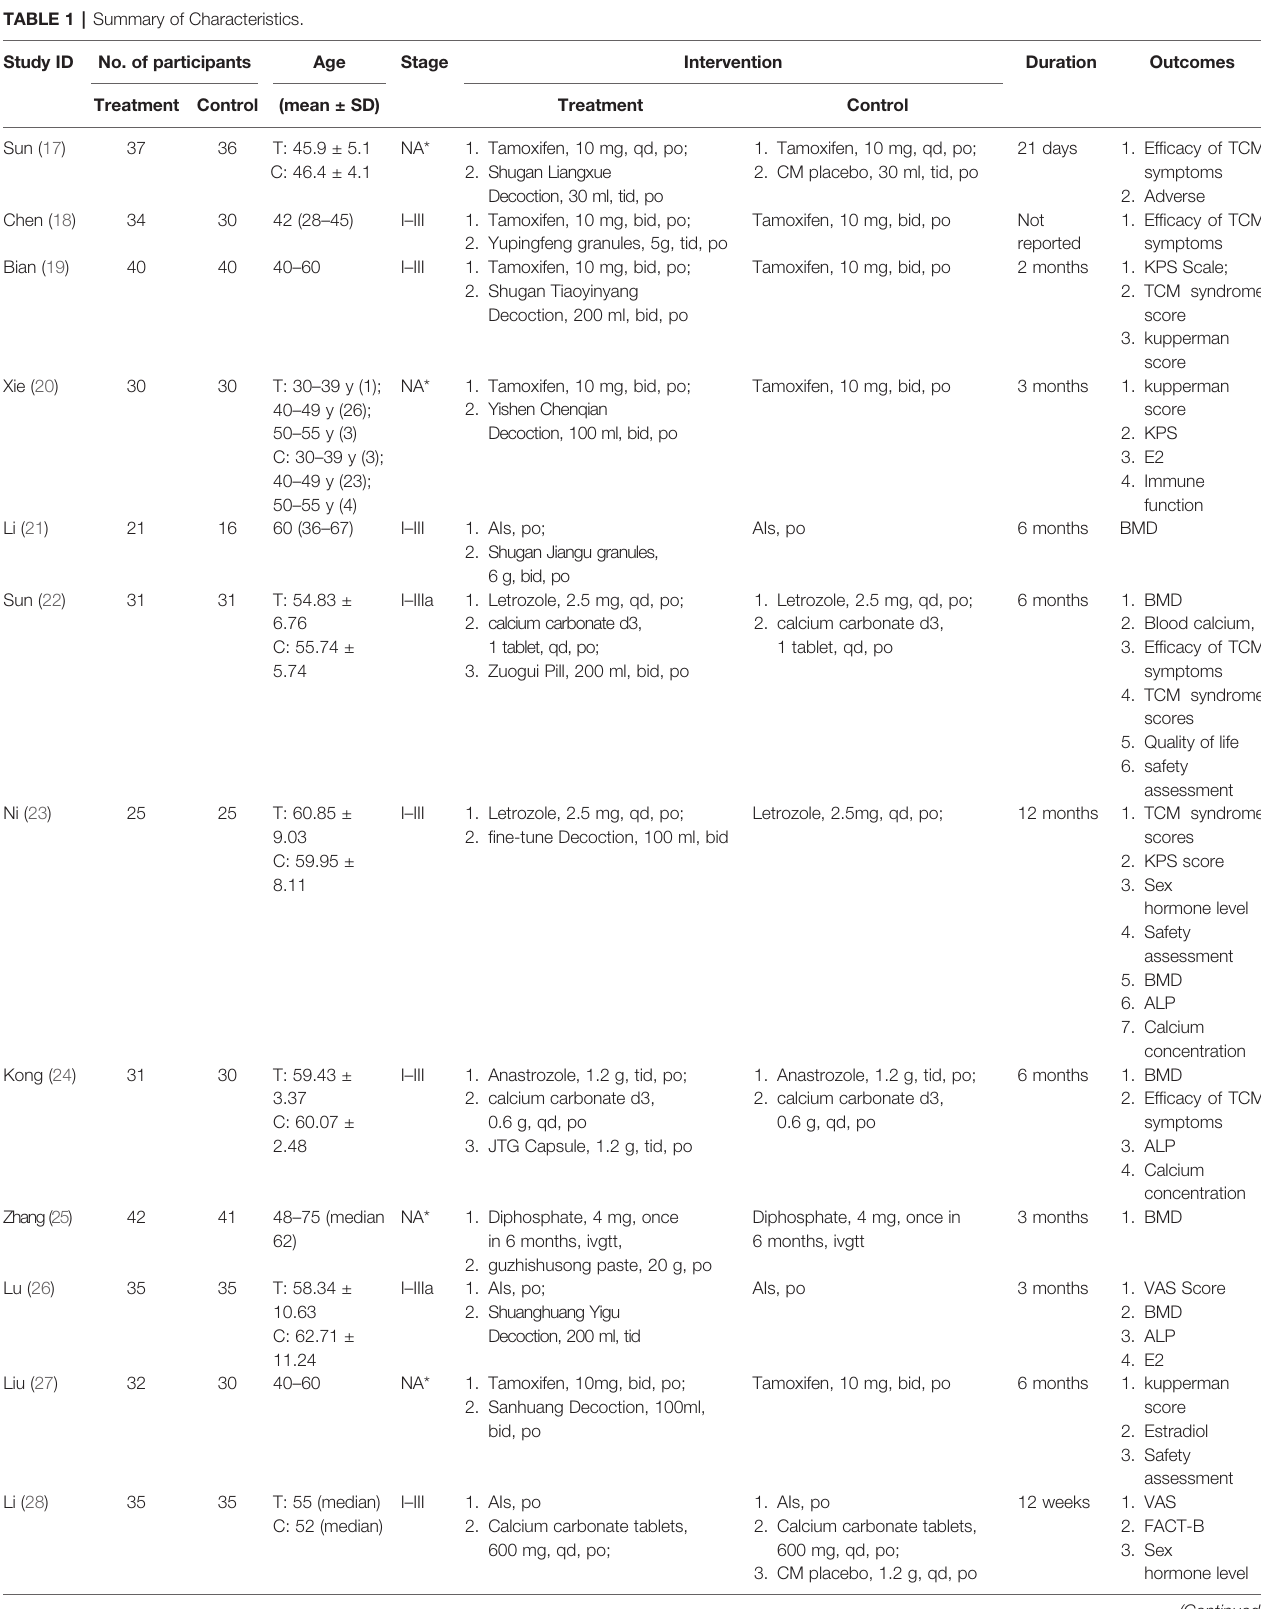
TABLE 1 | Summary of